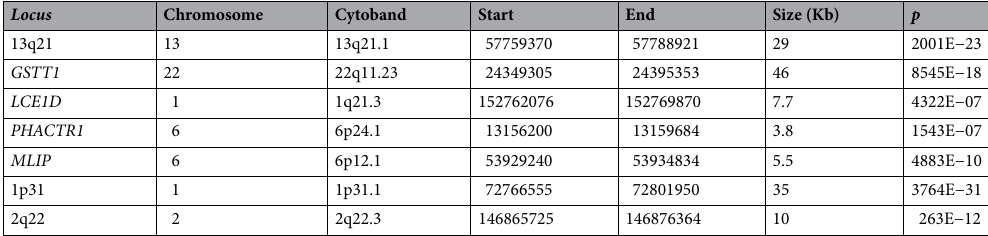
Table 3. Genomic loci and differences in copy numbers for responder and non-responder pooled groups (genomic assembly GRCh37). GSTT1 , glutathione S-transferase theta 1; LCE1D , late cornified envelope 1D; PHACTR1 , phosphatase and actin regulator 1; MLIP , muscular LMNA interacting protein.